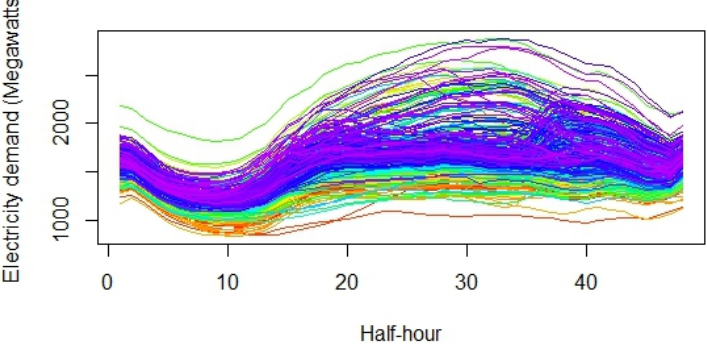
Figure 6. Electricity demand in Adelaide for Thursday.